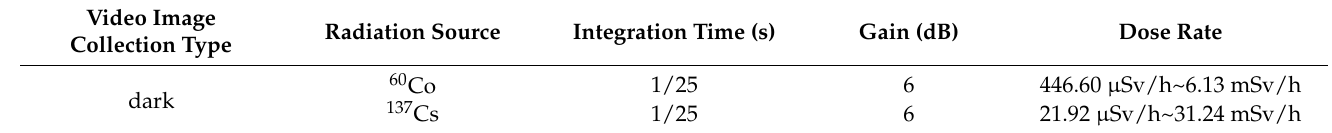
Table 2. Radiation experiment scheme of calibration chamber.